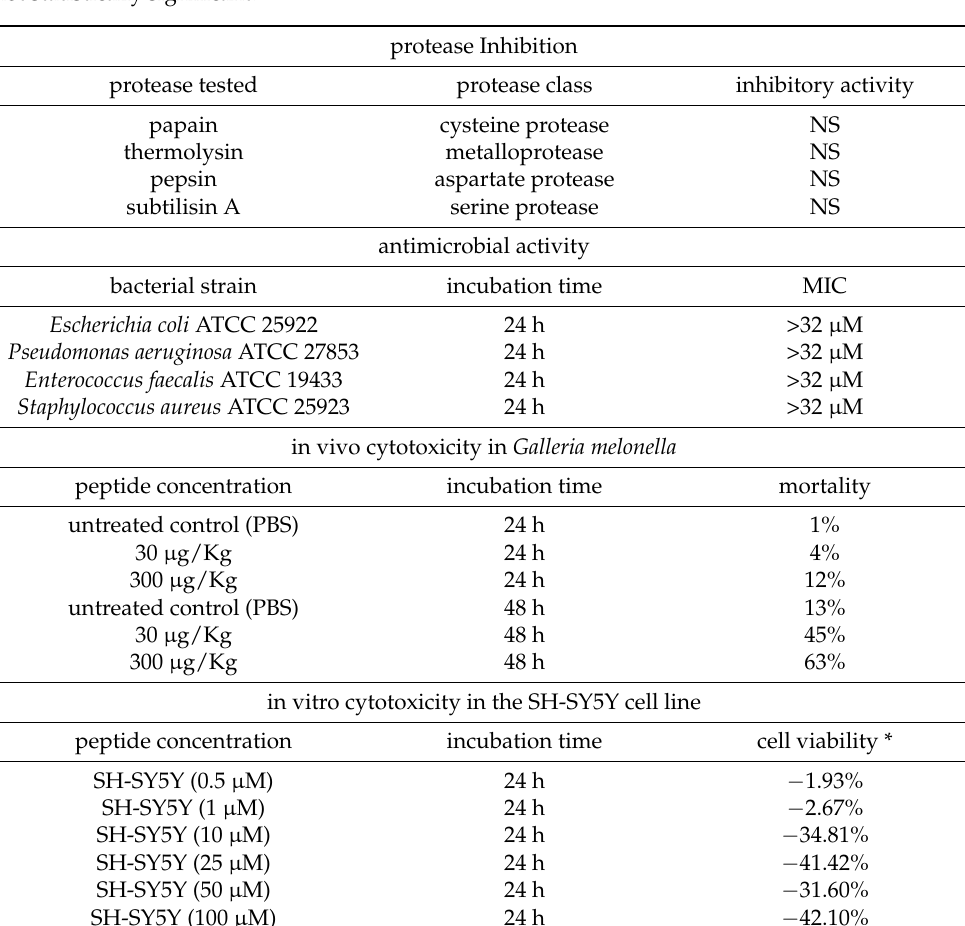
Table 1. Summary of the outcomes of the functional assays carried out on the sCRP-I H1 peptide. NS: not statistically significant. protease Inhibition protease tested protease